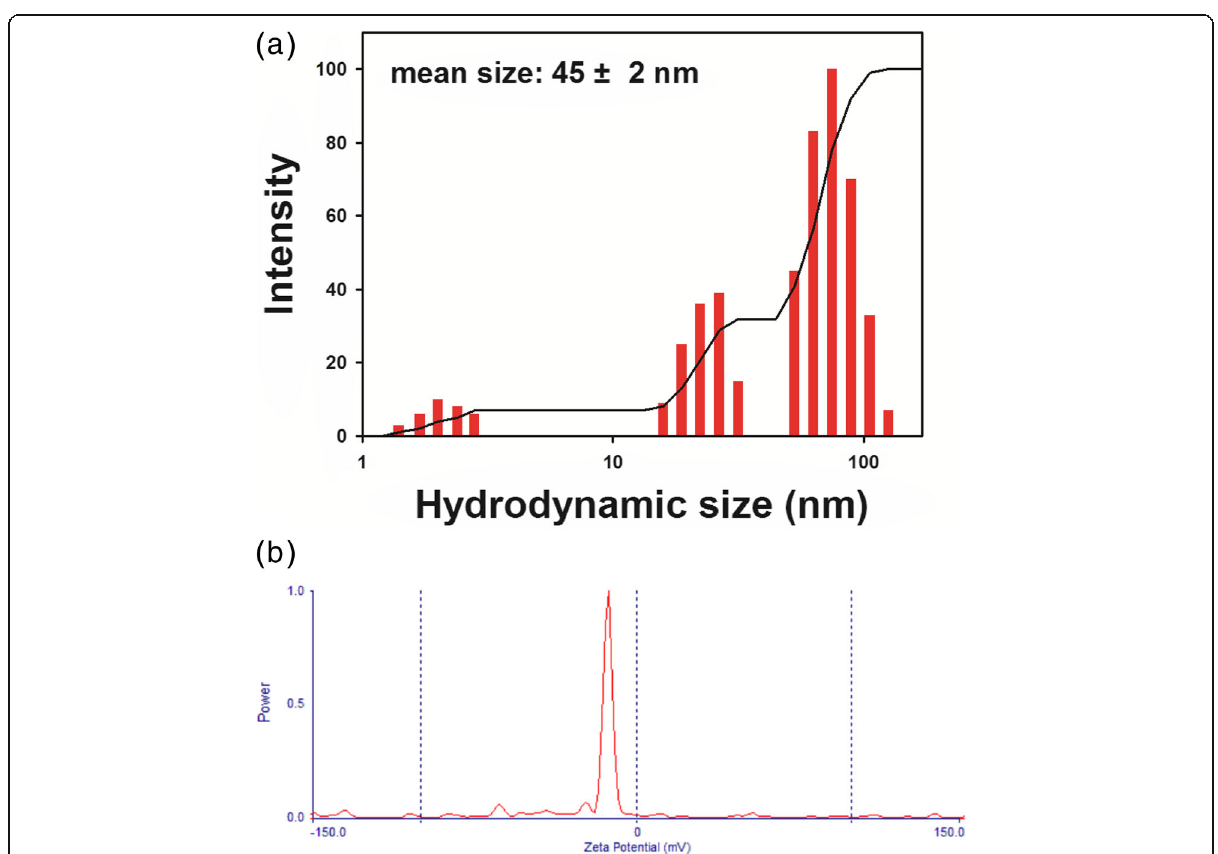
Fig. 6 Hydrodynamic size and zeta potential of PV-AuNPs. a Hydrodynamic size. b Zeta potential